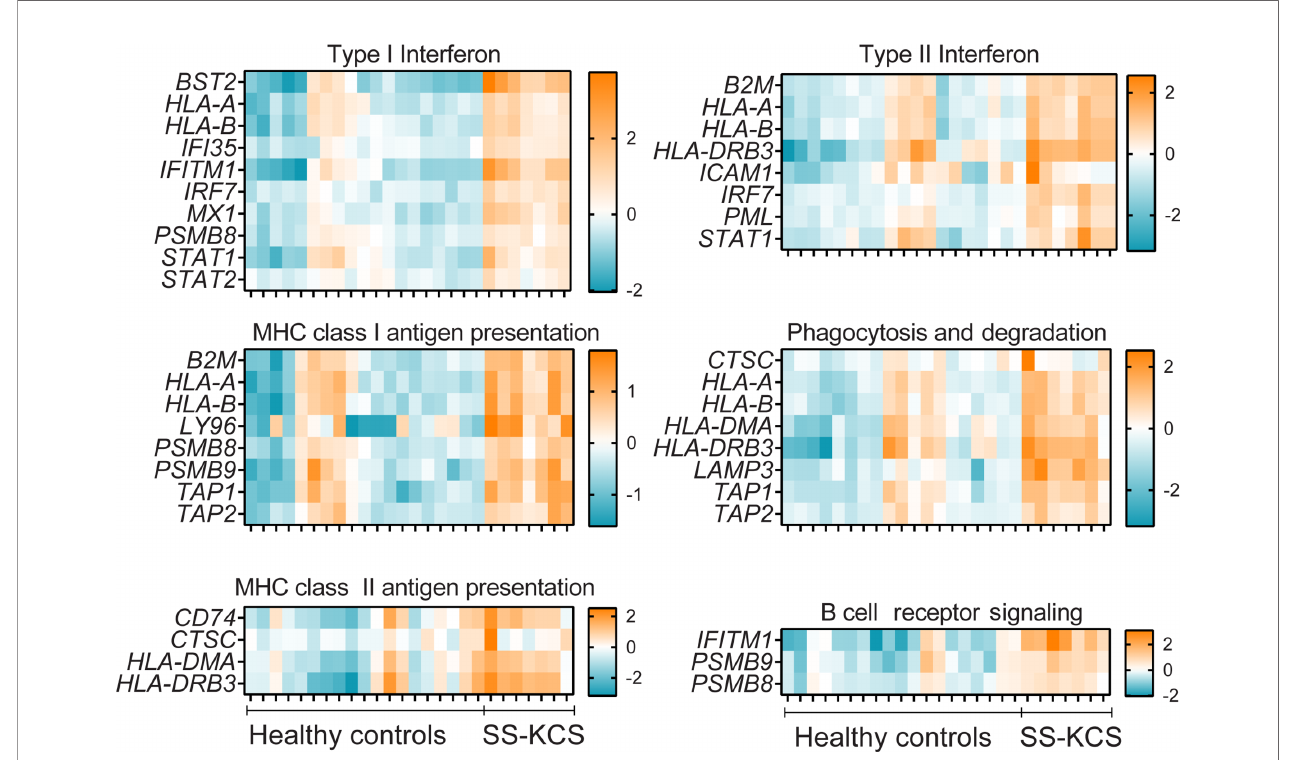
FIGURE 2 | A heatmap of expression of immune pathways that were upregulated in SS KCS conjunctiva. Heatmaps show Type I and II Interferon, MHC class I and II antigen presentation, phagocytosis and degradation, and B cell receptor signaling